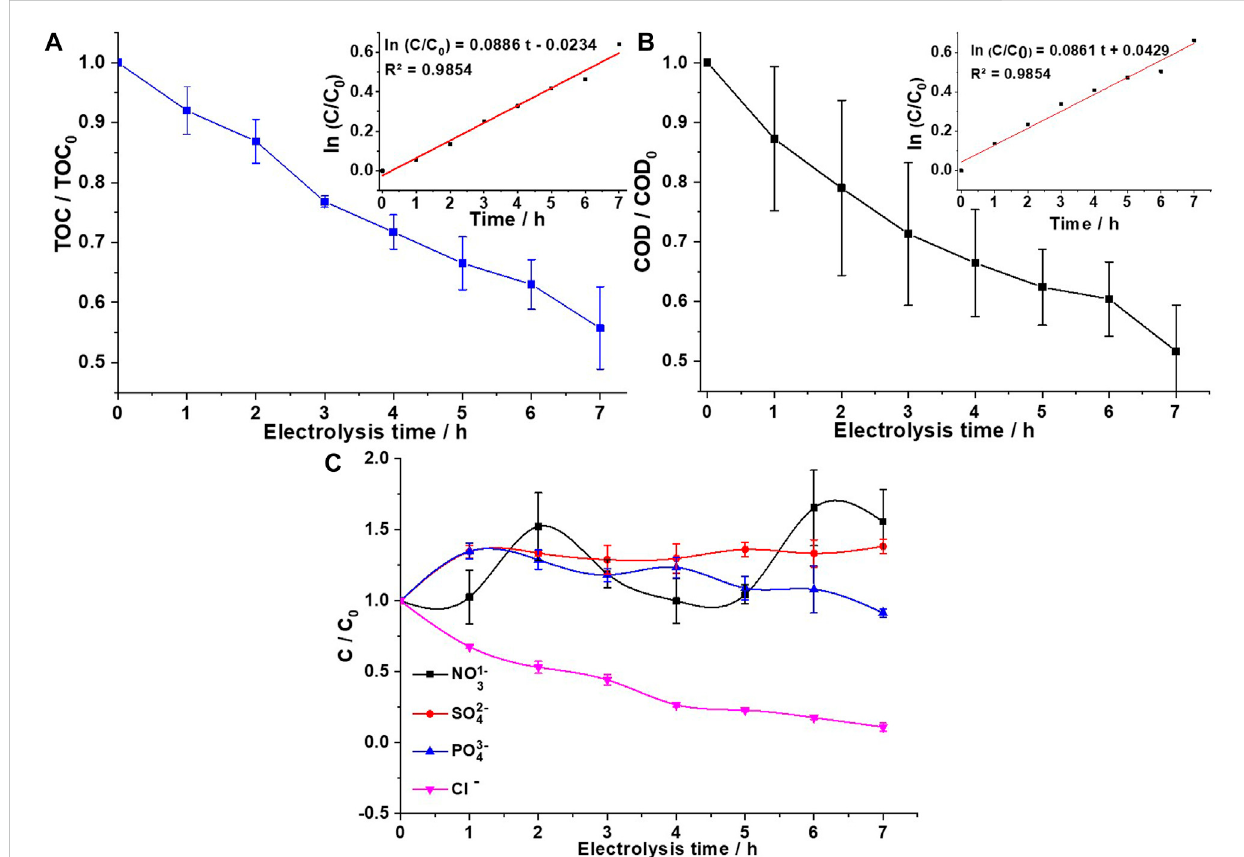
FIGURE 5 (A) TOC removal from domestic wastewater at a current density of 14 mA cm − 2 and recirculation fl ow rate of 1.5 L min − 1 . Inset: Pseudo- fi rst-order kinetics of TOC removal. (B) COD removal from domestic wastewater at a current density of 14 mA cm − 2 and recirculation fl ow rate 1.5 L min − 1 . Inset: